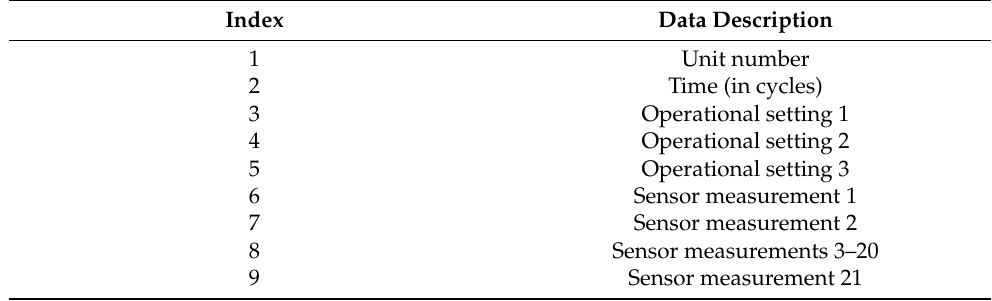
Table 1. Specifications of dataset.